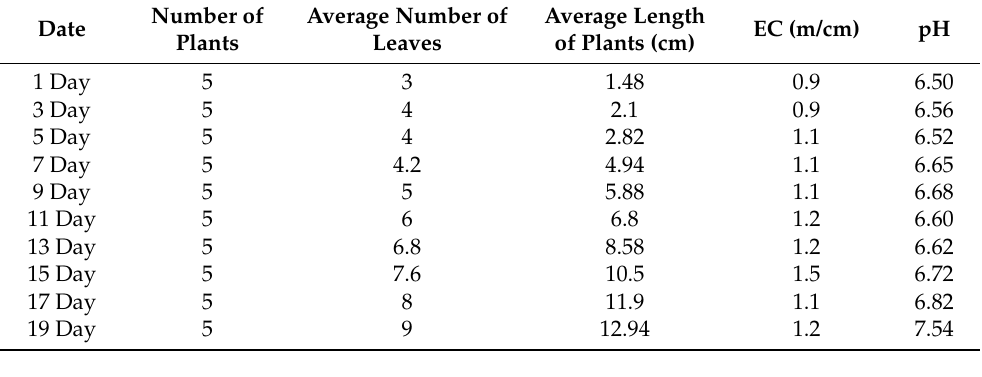
Table 9. Uncontrolled plant growth and observation system.